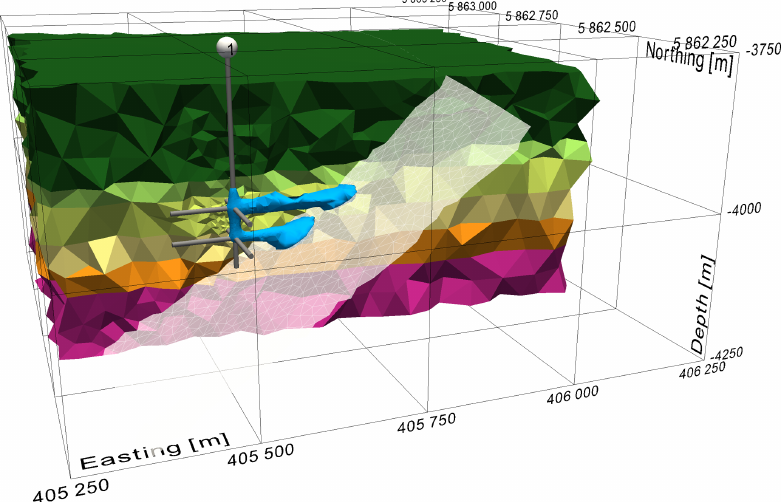
Figure 2. Setup of case 3, which is based on the Groß Schönebeck case and main fault F21n. Also shown are the different rock types, the well including the laterals connecting to fault F21n. For illustration purposes, around the laterals the injected water at the end of an injection period of 5 years is given (in